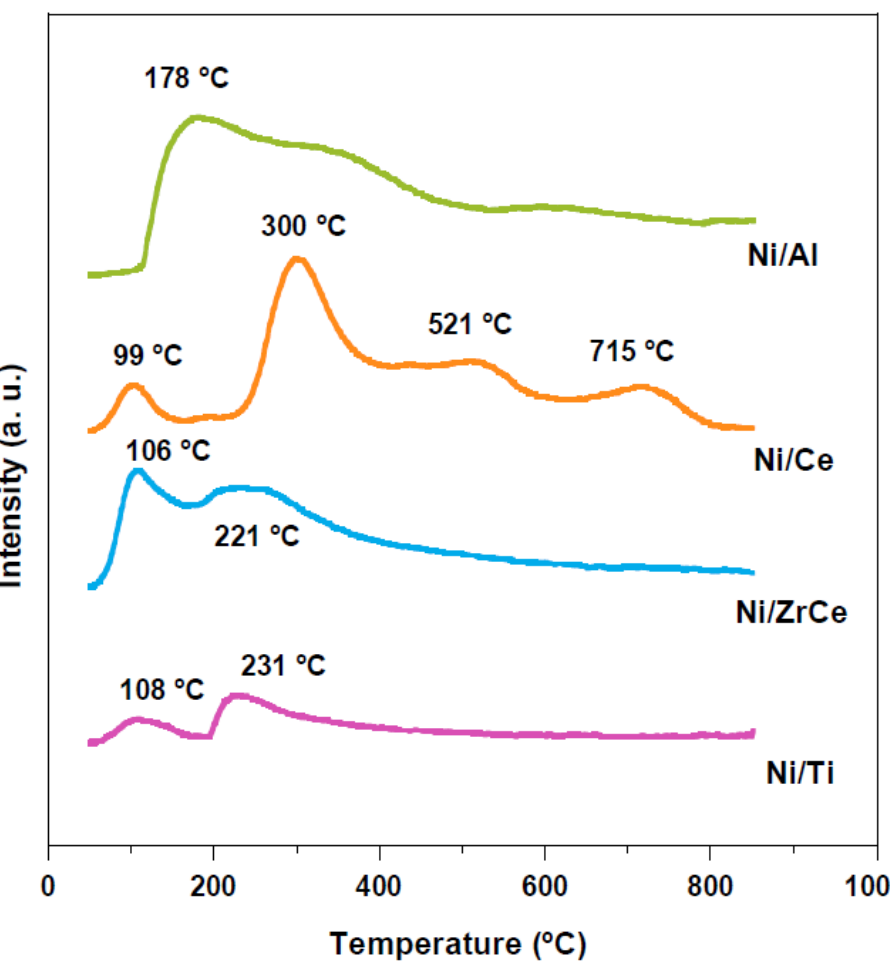
Figure 3. CO 2 -TPD profiles of the supported nickel catalysts freshly reduced at 500 ◦ C. Muroyama et al. [40] recorded a CO 2 -TPD profile for a 10 wt.% Ni on alumina catalyst that is very similar to the one corresponding to Ni/Al (Figure 3). The large amount of CO 2 desorbed was related to the high surface area of the catalyst, and the wide temperature range (100–500 ◦ C) within which desorption takes place was related to the presence in the material of a big variety of basic sites with several strengths. As for the amount of CO 2 desorbed, the value recorded with Ni/Al (386 µ mol CO 2 /g cat. ) is of the order of magnitude of the values reported in the literature, or even slightly higher than such values reported in the literature (262 µ mol CO 2 /g cat. and 316 µ mol CO 2 /g cat. for 10 wt.% Ni [41] and 15 wt.% Ni [66] on alumina catalysts, respectively). As for Ni on the reducible supports, the carbon dioxide adsorption capacity of Ni/Ce (196 µ mol CO 2 /g cat. ) is remarkably higher than the one found by Italiano et al. [66] for a 15 wt.% Ni on ceria catalyst (56 µ mol CO 2 /g cat.